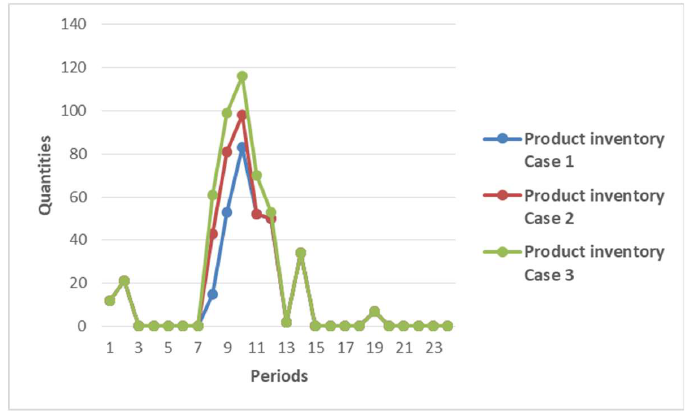
Fig.7. Product stock for the three cases